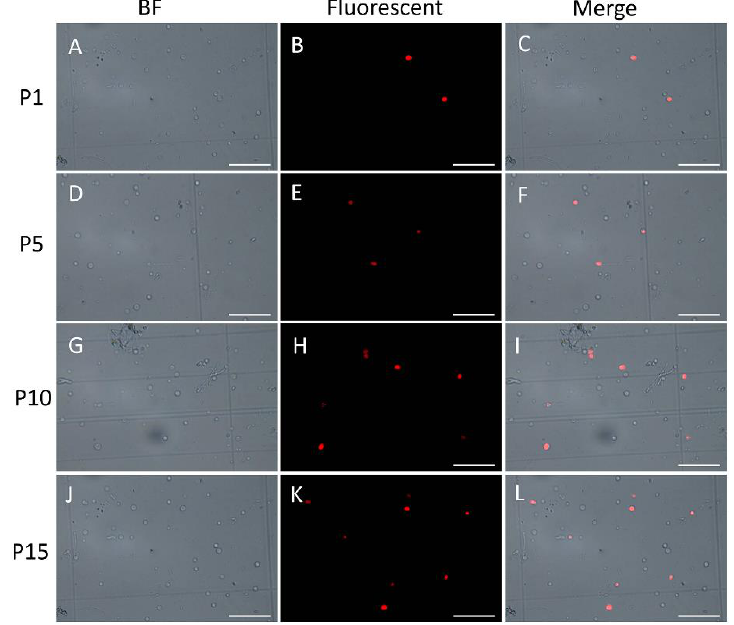
Figure 6. TUNEL assay of the subcultured mycelium from di ff erent generations. A – C , 1st generation; D – F , 5th generation; G – I , 10th generation; J – L , 15th generation. Bars = 10 µ